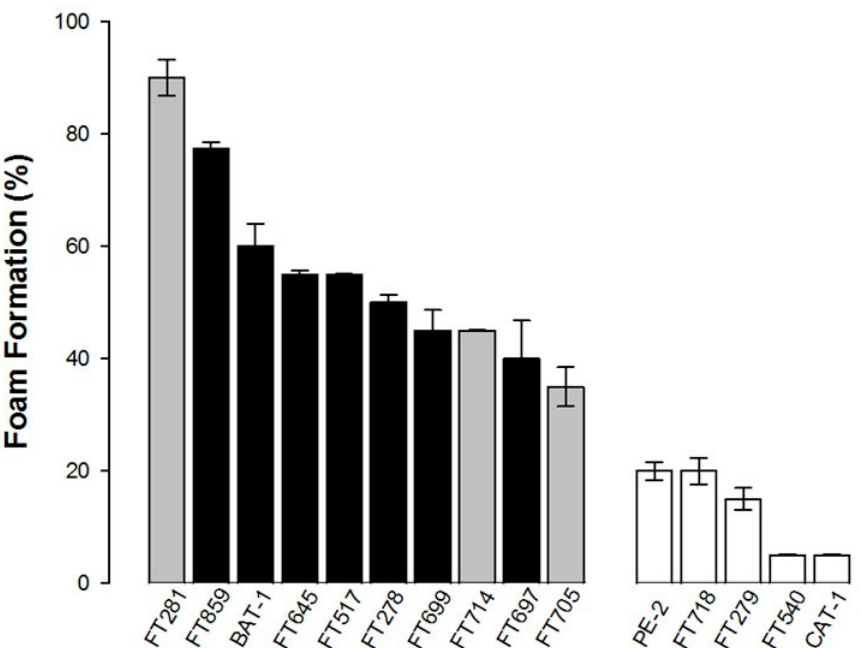
Figure 2. Foam produced during fermentation (volume of foam as a percentage of the media vol- ume) by the analyzed industrial fuel-ethanol yeast strains. White columns are strains that produce small amounts of foam, gray columns are strains that produce a non-persistent foam, and persistent foaming strains are in black columns.